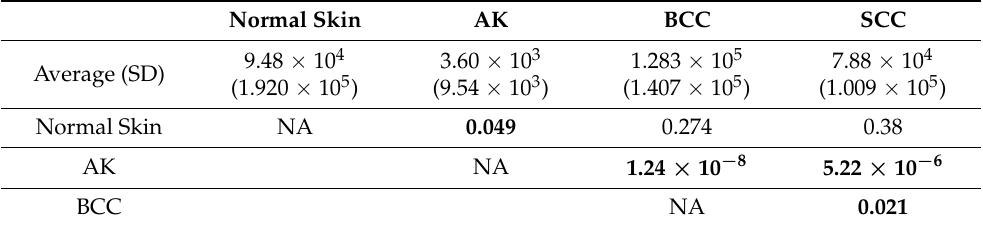
Table 2. Statistical analysis for p -values for VOCT measurement for weighted displacement peak heights in m for audible sound frequency of 260 Hz *. The sample size is the same as in Table 1 for each group.